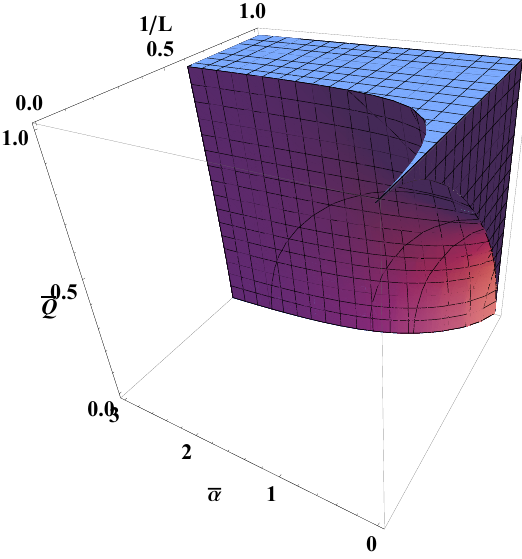
Figure 4 . The unstable region of de Sitter charged Gauss-Bonnet black hole with ‘ = 2 is shown in ( (cid:11); Q; L ) space.